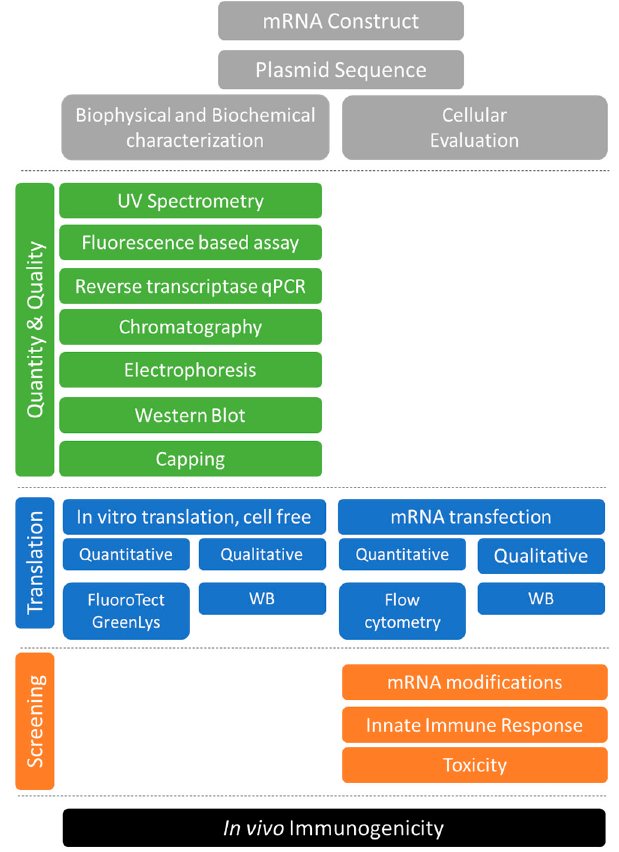
Figure 1. Tools for the quality control and cell-based functional evaluation of mRNA vaccine 59